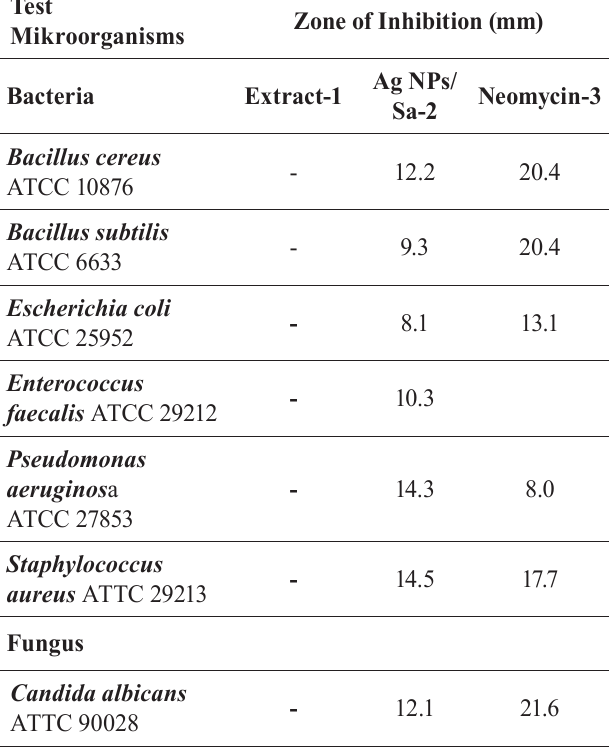
TABLE I - A ntimicrobial activity results